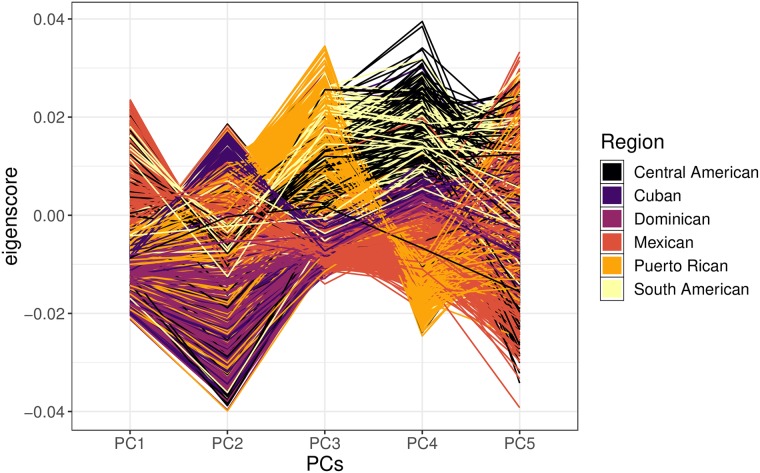
Genotypic principal component eigenscores of HCHS/SoL participants by self-identified region.Each line represents an individual in HCHS/SoL connected by their eigenscores calculated in KING and colored by self-identified region. Hispanic populations are mainly admixed between Native American, West African, and European populations, resulting in a genetically diverse and structured cohort under the umbrella term “Hispanic”.